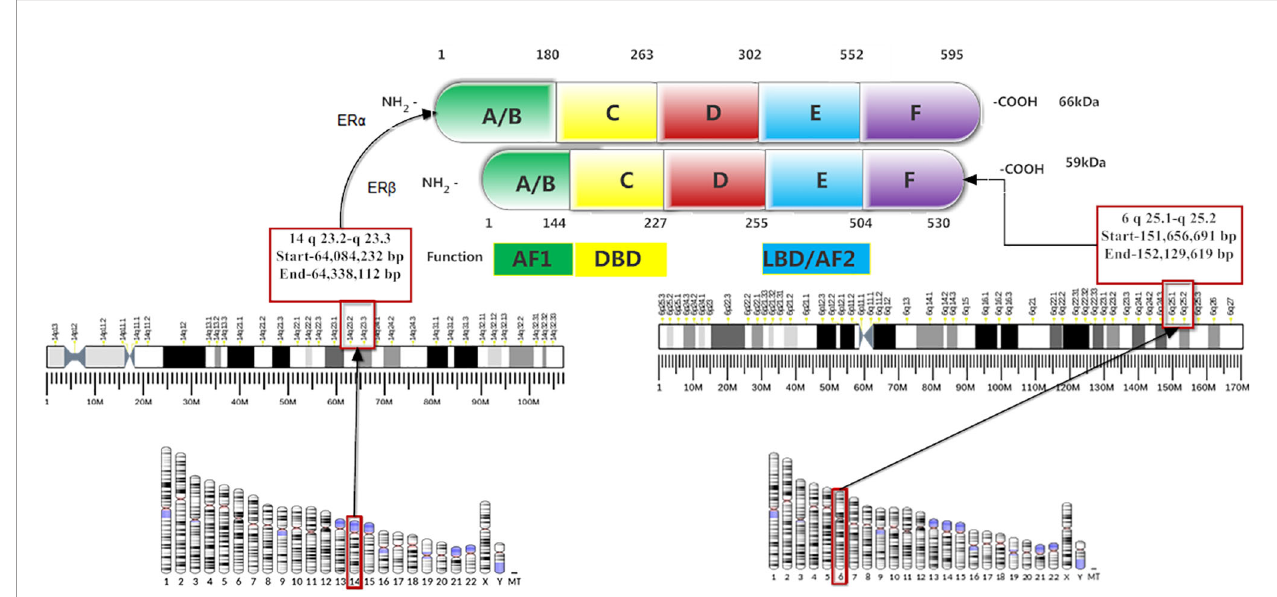
FIGURE 1 | Structure and functional domains of the estrogen